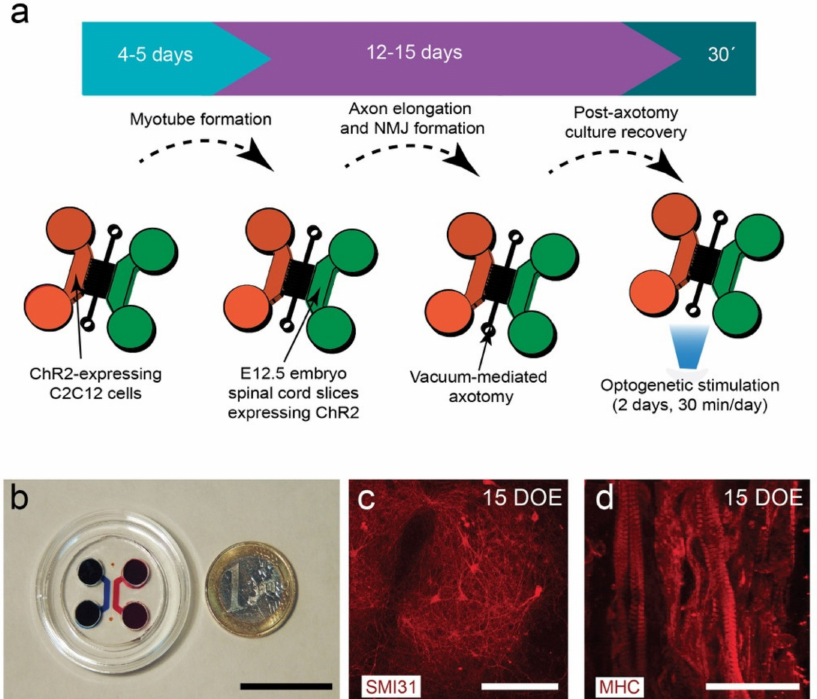
Figure 1. ( a ) General pipeline of the establishment of an optogenetically modular neuromuscular junction (NMJ) compartmentalized microfluidic platform (see Material and Methods for details). ( b ) Low magnification photomicrograph of the assembled microfluidic device. ( c )